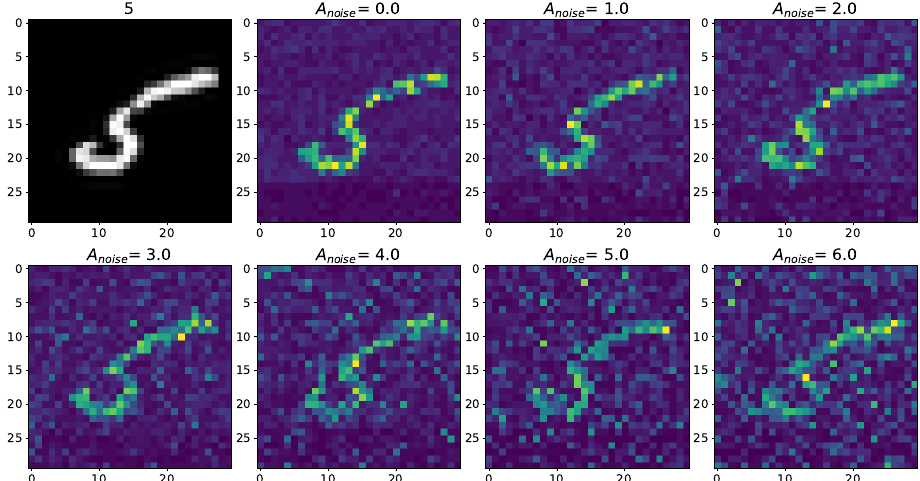
Figure A7. Changes in the spatial sweep of the spiking neural network during the representation of the supplied image from the Figure A5 when the amplitude, A noise , of the noise current, I noise , changes from 0 to 6 with modulation of neuronal activity by